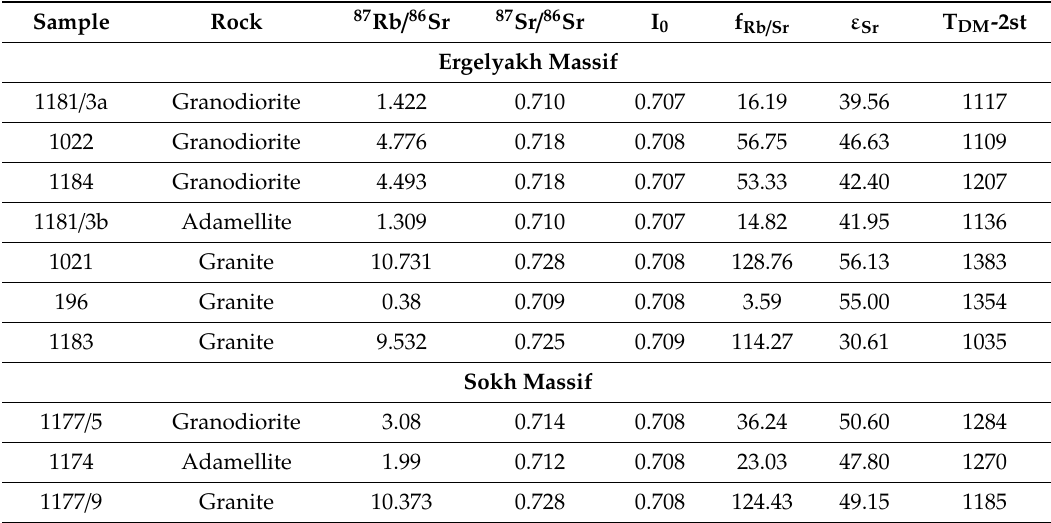
Table 7. Model Rb–Sr age and parameters of protoliths for EIRGD granitoids.